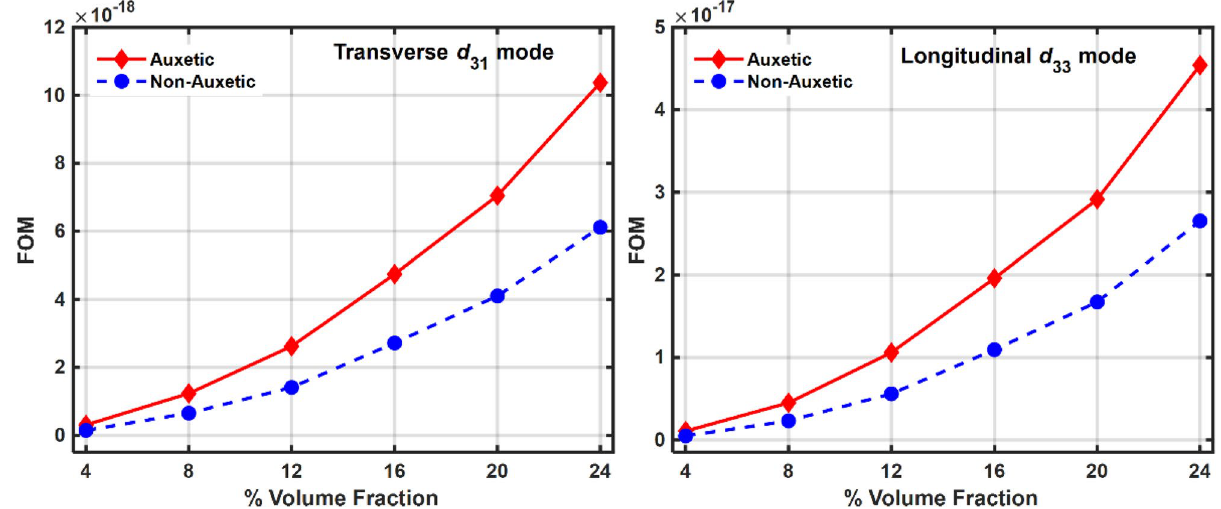
Figure 13. Variation of FOM with volume fraction for both Auxetic and Non-Auxetic materials in ( a ) Transverse ( d 31 ) mode and ( b ) Longitudinal ( d 33 )